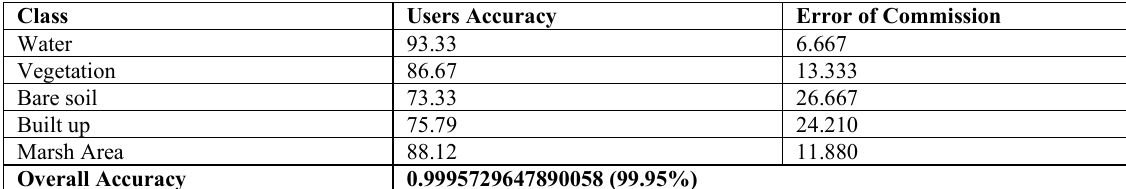
Table 3. Accuracy Assessment statistics